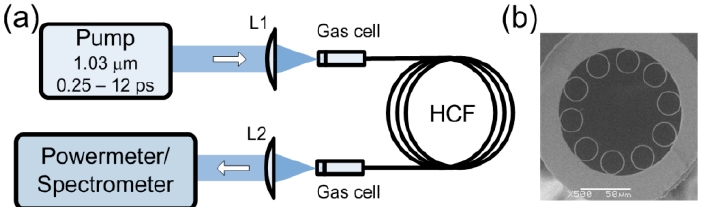
Figure 1. ( a ) The scheme of experimental setup; ( b ) SEM image of the hollow-core fiber cross-section. The HCF was filled with D 2 at various pressures in the range from 5 to 30